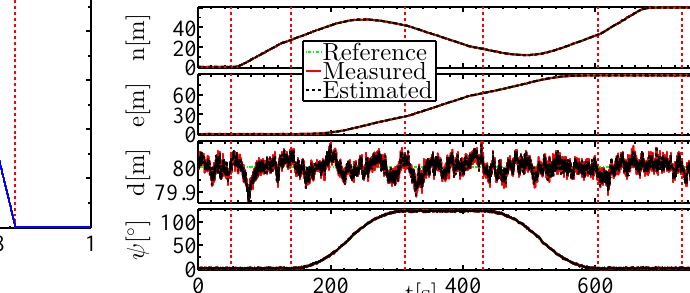
Figure 11: Reference path curvature.